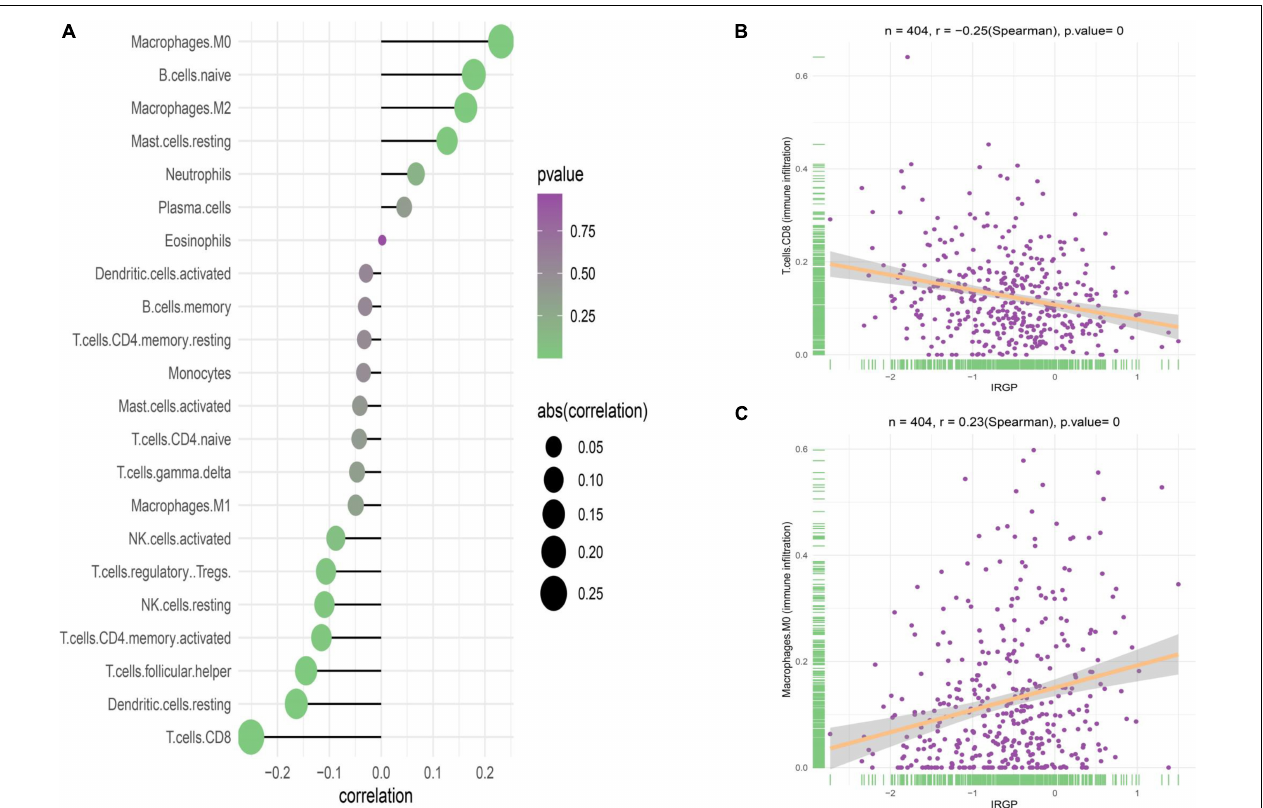
FIGURE 6 | Correlation of the two groups with immune infiltration. (A) Correlation of the two groups with 22 immune cells. (B) Correlation between CD8+ T cell abundance and IRGP-signature. (C) Correlation between macrophages M0 cell abundance and IRGP-signature. IRGP, immune-related gene pair.